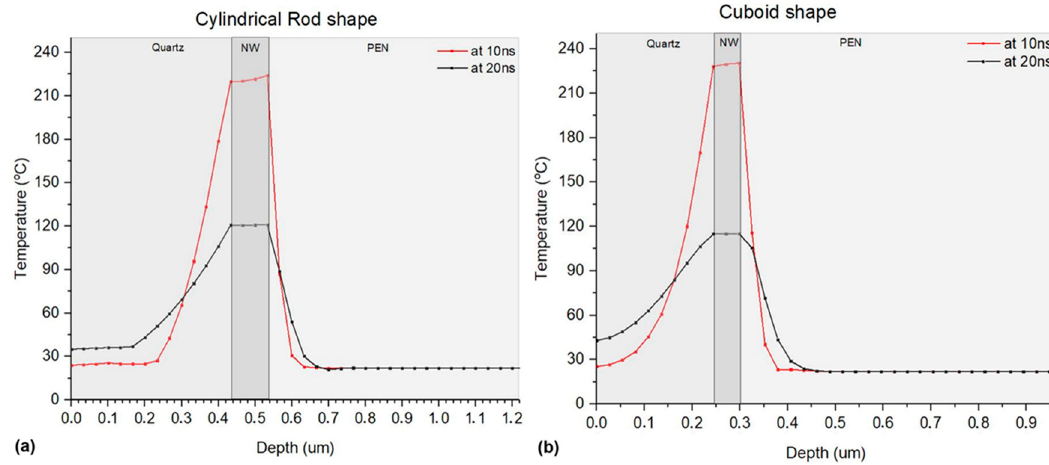
Figure 9. In-depth temperature distribution around the interface of quartz/Ag NW/PEN. Two different time moments are presented: The time corresponding to the maximal achieved temperature, immediately after the end of the effect of the pulse (10 ns), the time of the maximization of the heat affected zone in PEN (20 ns) an ( a ): cylindrical rod shape. At 10 ns the maximal achieved temperature at the interface (226.4 ◦ C) goes down to below 100 ◦ C at 50 nm in the interior of PEN. At 20 ns the heat affected zone is maximized at 100 nm depth. ( b ): cuboid parallelepiped shape. At 10 ns the maximal achieved temperature at the interface (241.5 ◦ C) goes down to below 100 ◦ C at 50 nm in the interior of PEN. At 20 ns the heat affected zone is maximized at 110 nm depth. Heat is also conducted to the interior of the quartz substrate, which is an indication that the presence of quartz contributes significantly to the heat dissipation.